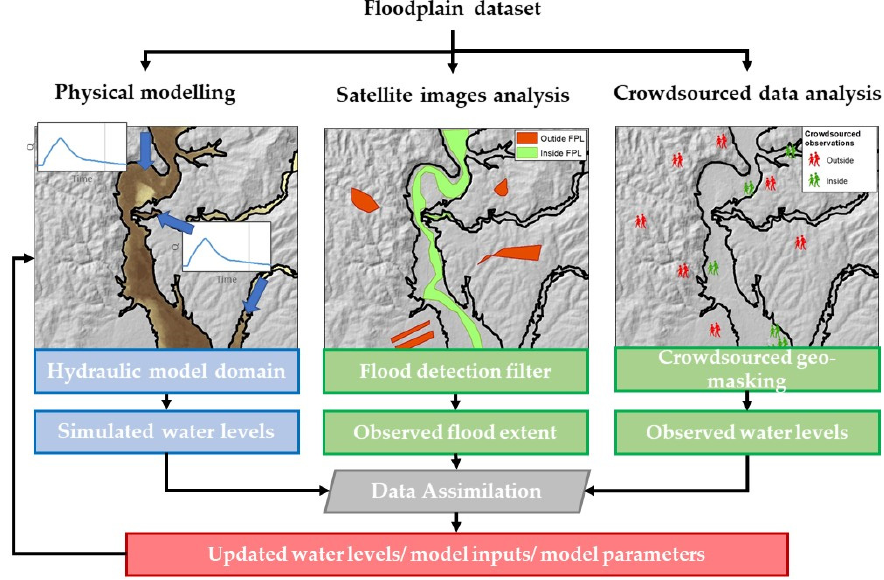
Figure 3. Flowchart depicting the integration of the GFPLAIN dataset into a Data Assimilation (DA) framework for flood forecasting.